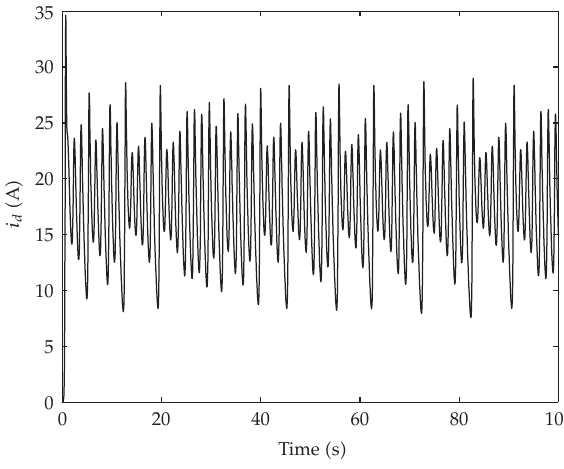
Figure 3: The i d curve of the chaotic PMSM drive system without u d